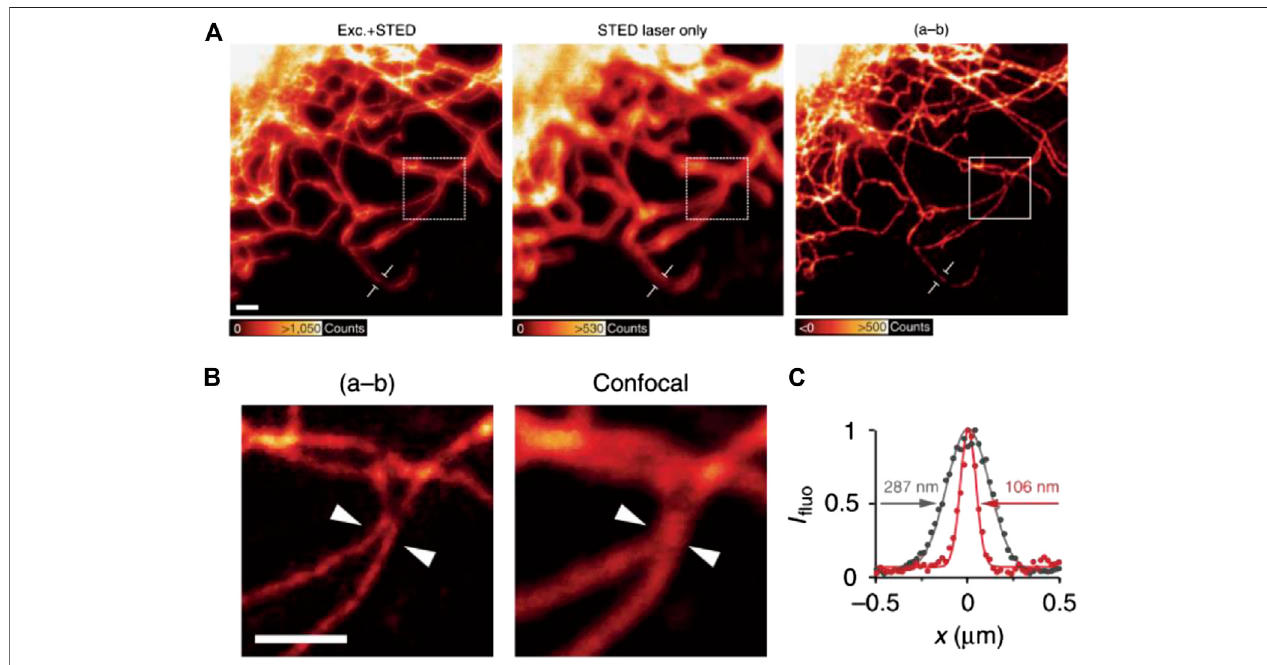
FIGURE 7 | STED imaging of vimentin fi bers labeled with commercial QDot705 (Hanne et al., 2015). (A) Fluorescence signal acquired by applying excitation + STED, STED light only, and the fi nal image corrected by subtraction. (B) The comparison of resolution of corrected STED image and confocal results. (C) Plot fi le for confocal and corrected STED results in the region of